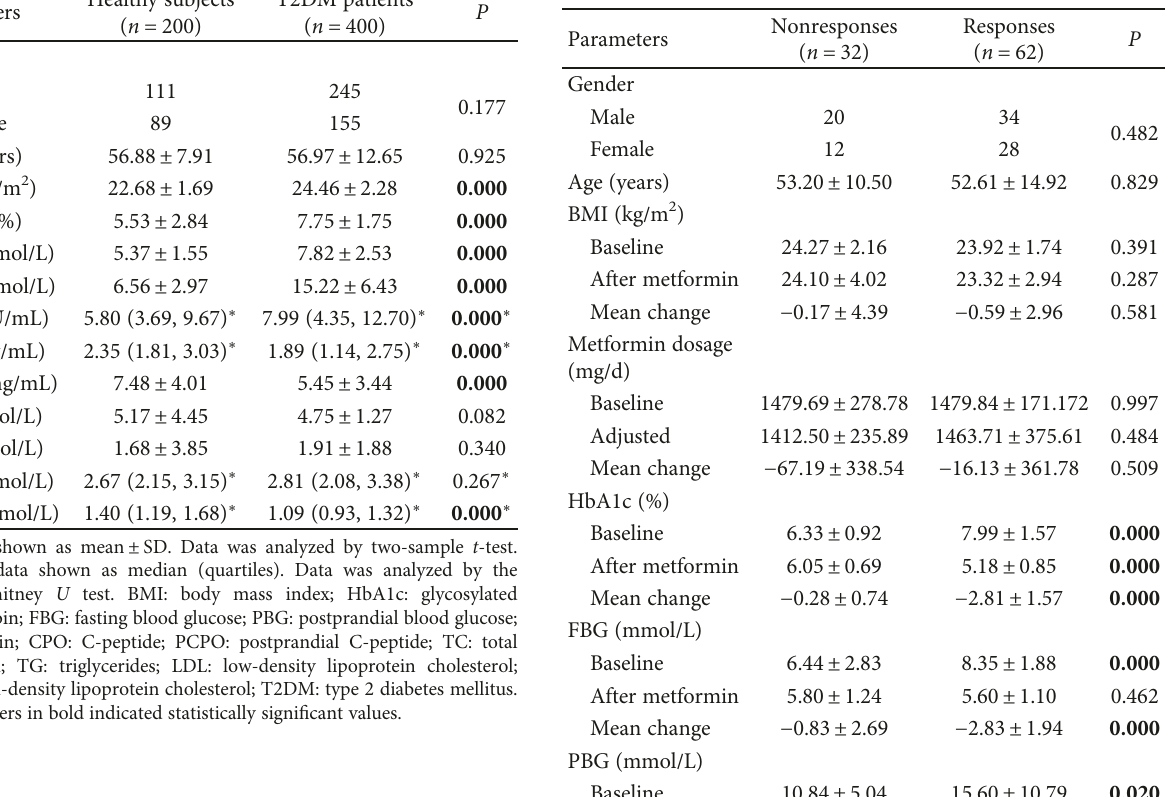
Table 3: Comparison of clinical characteristics between the responders and nonresponders before and after metformin